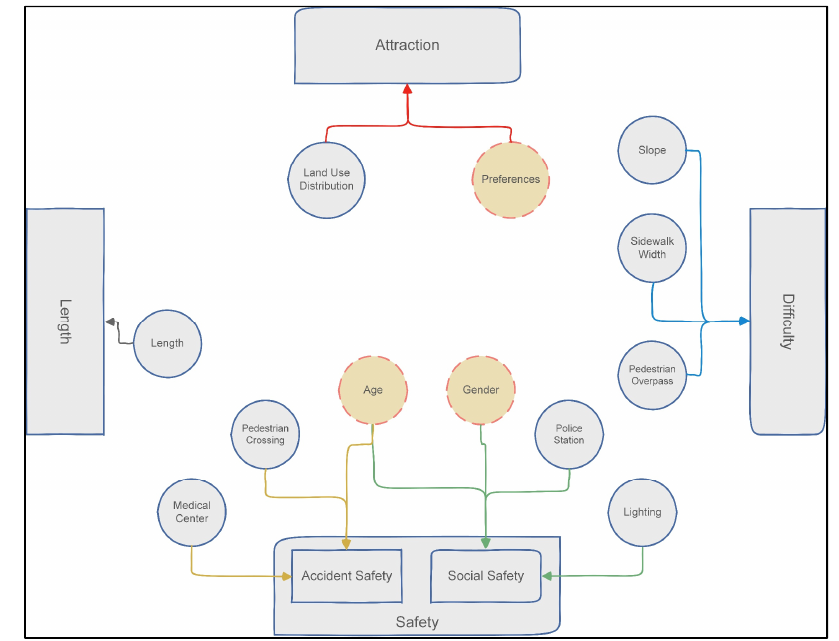
Figure 1. The proposed Framework for UPWFS